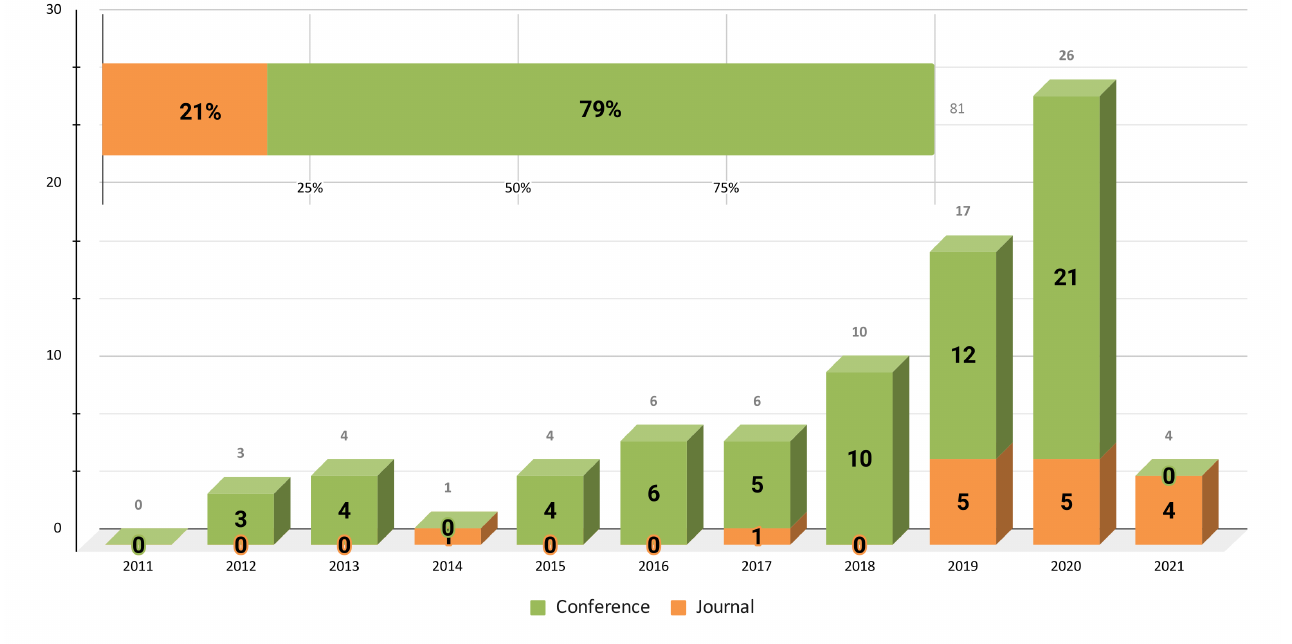
Figure 5. Evolution of the